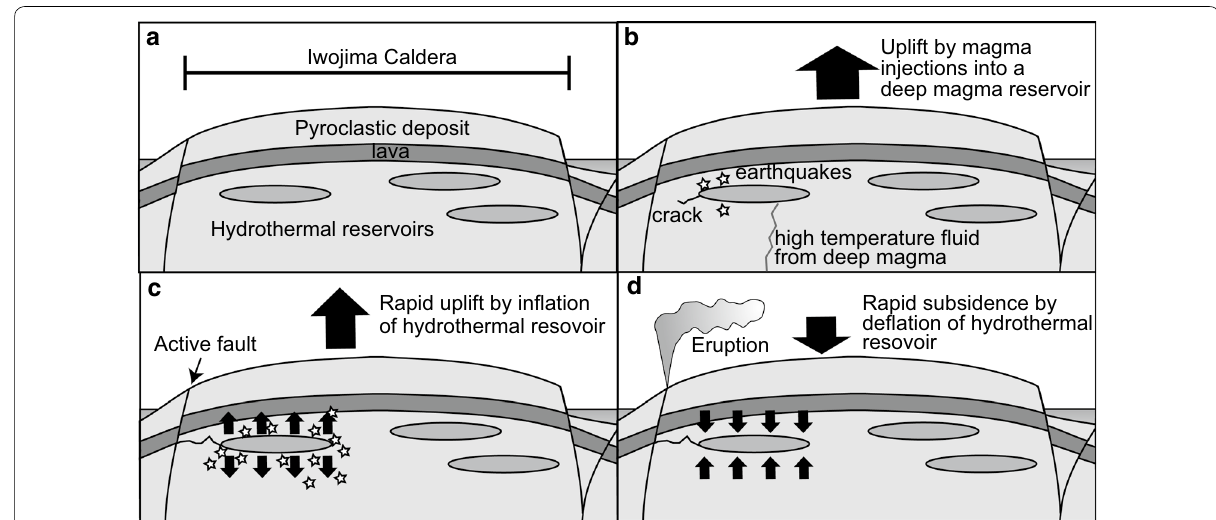
Fig. 10 A schematic illustration of an inferred mechanism of phreatic eruptions accompanied by precursors in Ioto. a Before the eruption, hydro- thermal reservoirs were sealed beneath the lava layer and subjected to lithostatic pressure, and existing in a stable manner even at a relatively high temperature and high pressure. b Intermittent uplift and seismic activity cause a partial pressure decrease and a partial boiling point exceeded by supply of high temperature fluid from the deeper section due to a pressure increase in a magma chamber. c The horizontal planar hydrothermal reservoir inflates and leads to further pressure reduction and boiling. After that, if the tip of the planar reservoir hits an active fault or a crack, hot water is ejected and a phreatic eruption occurs. d After the beginning of the phreatic eruption, the planar hydrothermal reservoir rapidly